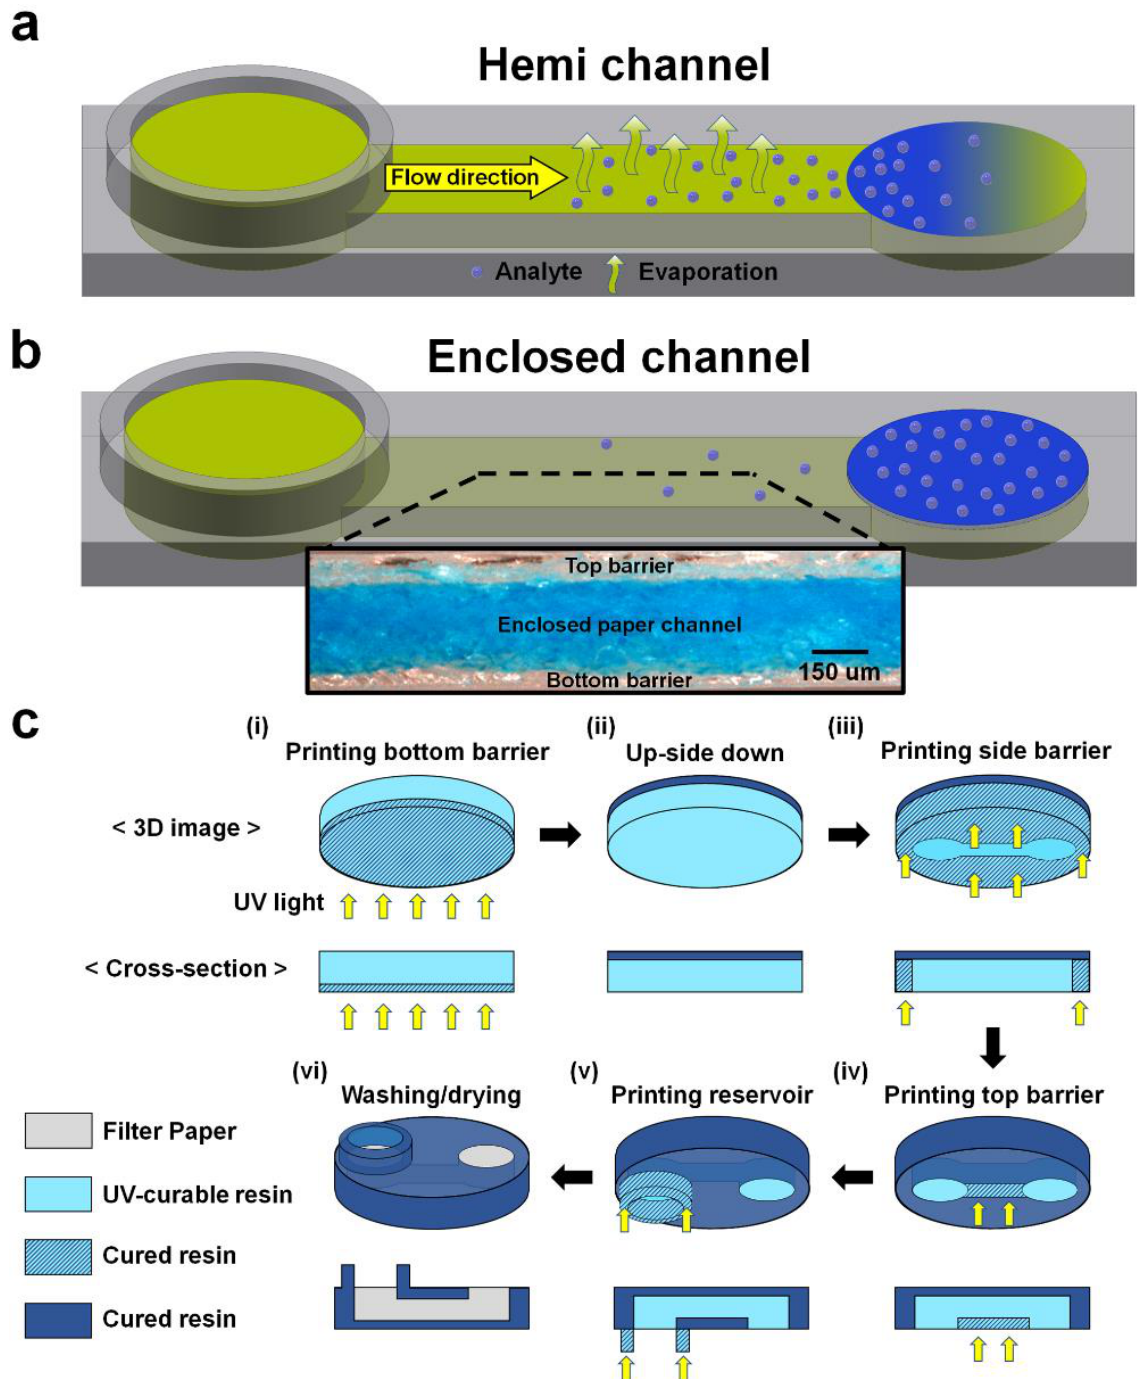
Figure 2. Schematics describing 3D models and printing steps of hemi and enclosed channels. 3D model of hemi ( a ) and enclosed ( b ) channels. ( c ) Vat photopolymerization steps to fabricate an enclosed channel in filter paper. The paper